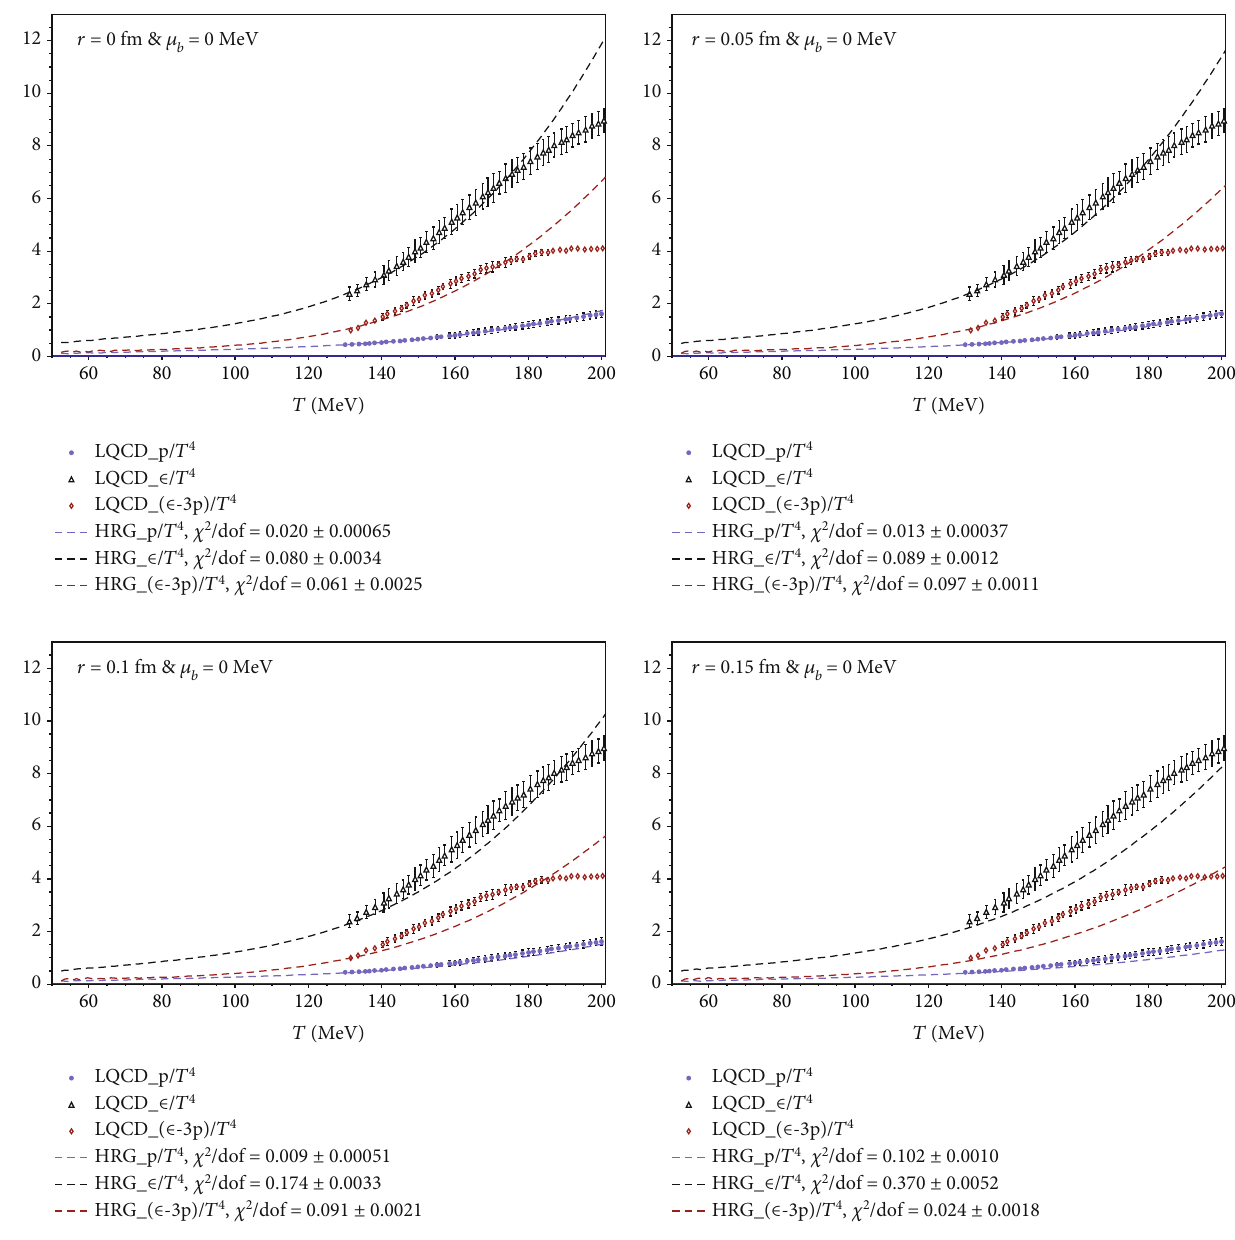
Figure 1: Normalized pressure P / T 4 , normalized energy density ρ / T 4 , and trace anomaly ð ρ − 3 P Þ / T 4 (dashed curves) calculated using our statistically corrected HRG model and confronted to the corresponding lattice data taken from Ref. [66] (symbols with error bars), = 0 MeV . Comparison is made for four di ff erent values of the correlation length r at μ b